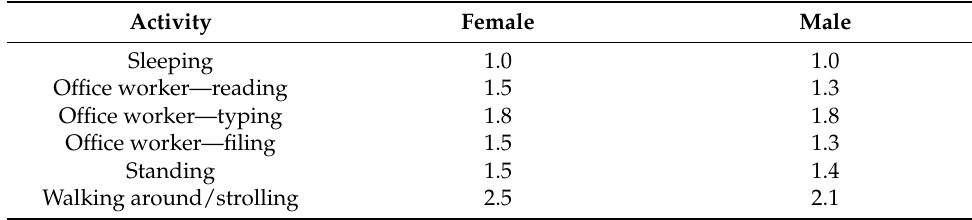
Table 3. PAR values for various activities [27].